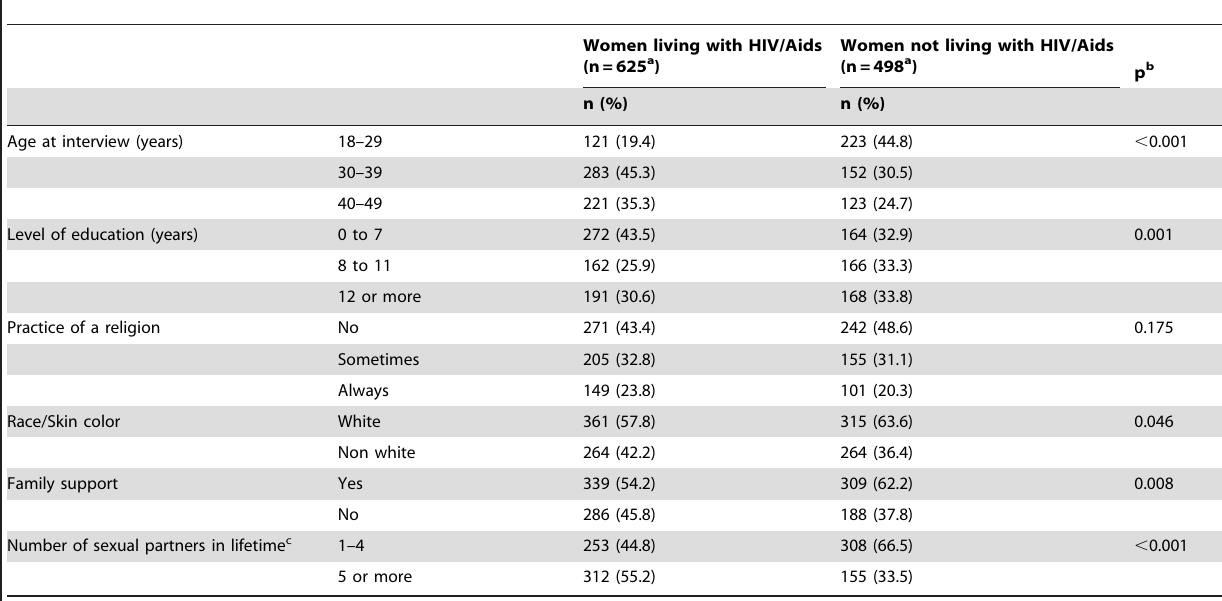
Table 1. Description of women living with HIV/AIDS and women not living with HIV/AIDS according to characteristics linked to the life course of women (variables refer to the time of the interview).